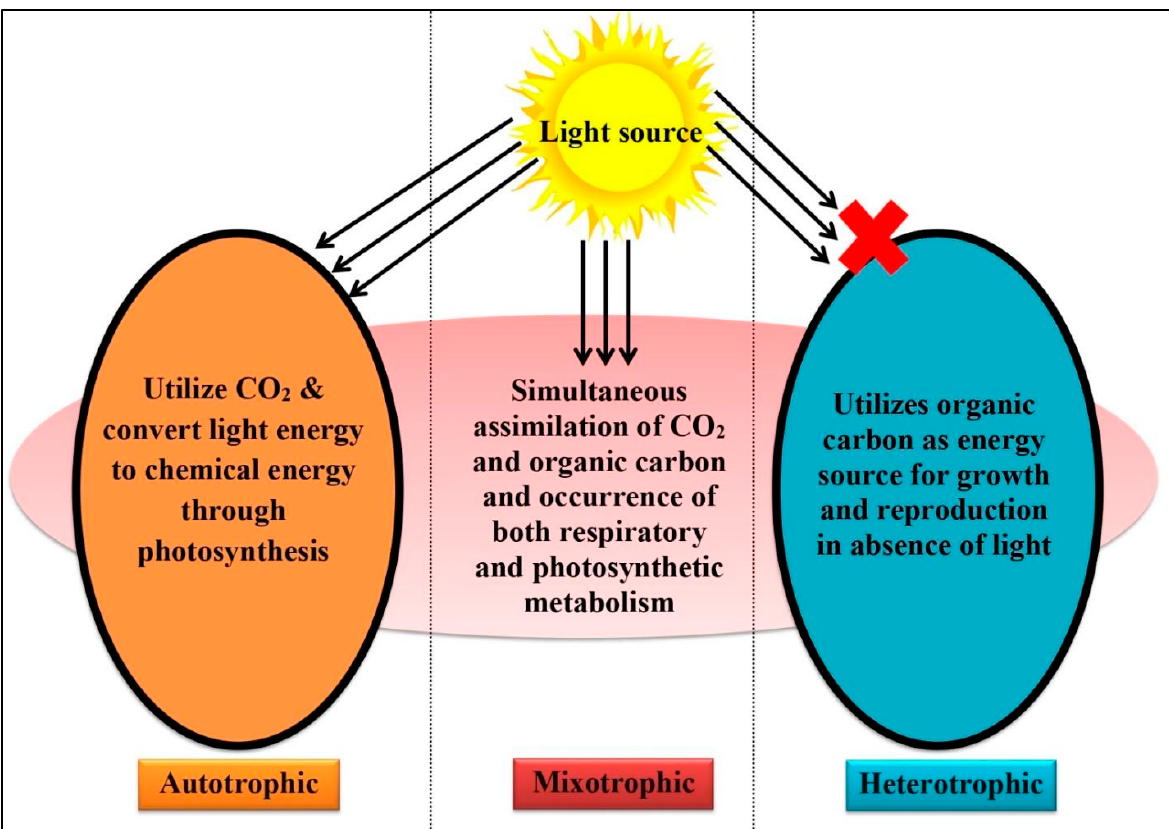
Figure 2. Different types of microalgae metabolism.